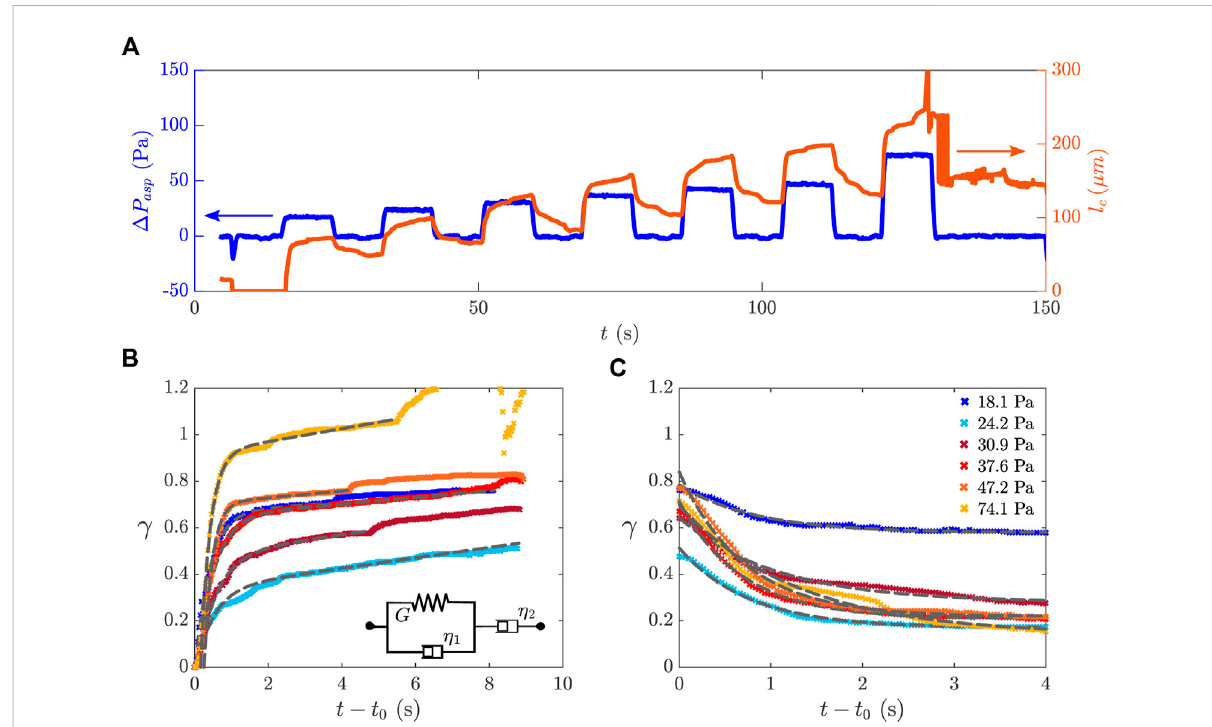
FIGURE 3 Exampleofanaspirationexperimentanditsdatatreatment.Theprobedprototissuewasobtainedwiththeassemblyof2%-biotinGUVsandhad a size of w *~2.1. (A) Applied aspiration sequence consisting of several pressure steps ( Δ P asp , shown in blue) and the corresponding evolution of the contactlength, l c (orange).Thepressuresequencestartswithakickwithnegativepressuretoensurethatthetemporalcorrespondencebetweenthe pressure signal and the image acquisition was correct. After each positive (aspiration) step, a small negative pressure of 2 Pa was applied over 1.5 s to insure a complete relaxation of the prototissue before each pressure step was applied. (B) Time aligned strain curves γ ( t ) for each pressure step during the creep phases. The dashed lines show the best fi t to the model (Eq. 2). The inset shows the diagram corresponding to the generalized Kelvin-Voigt fl uid model. (C) Time aligned strain curves γ ( t ) after each pressure step during the relaxation phases. The dashed lines show the fi tted model following Eq. 3. In (B) and (C) , colors correspond to different pressure